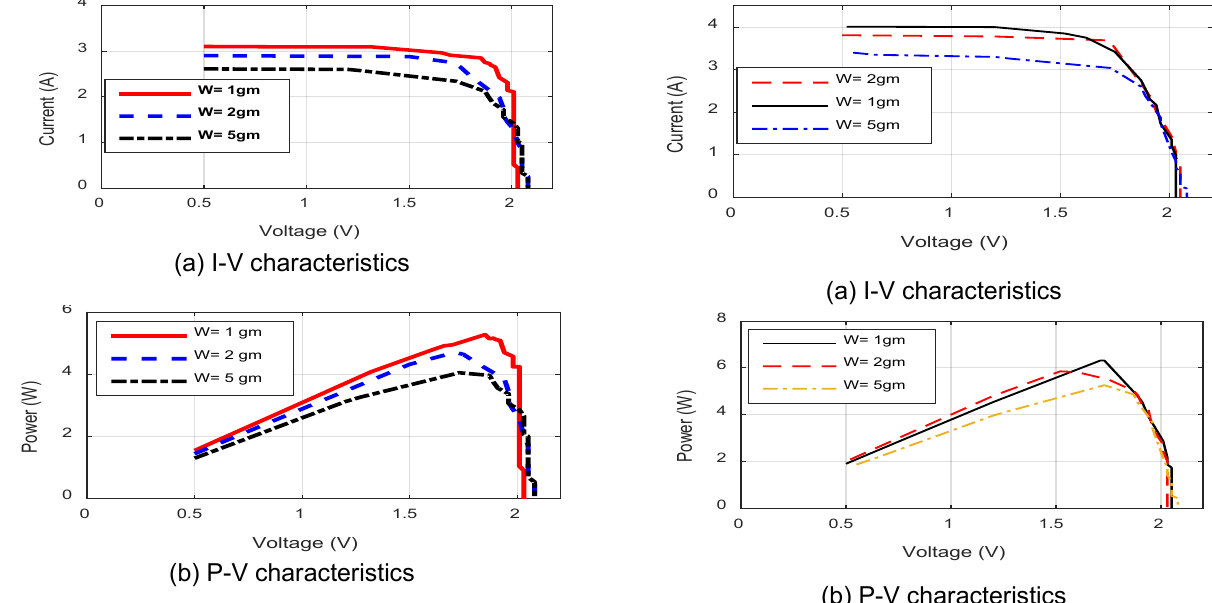
Figure 9. I-V and P-V characteristics with sugar mill Bagasse dust at 500W/m 2